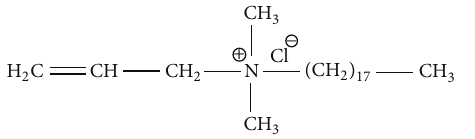
Figure 1: Molecular structure of 18-alkyl-dimethyl diallyl ammo- nium chloride (C 18 DMAAC).